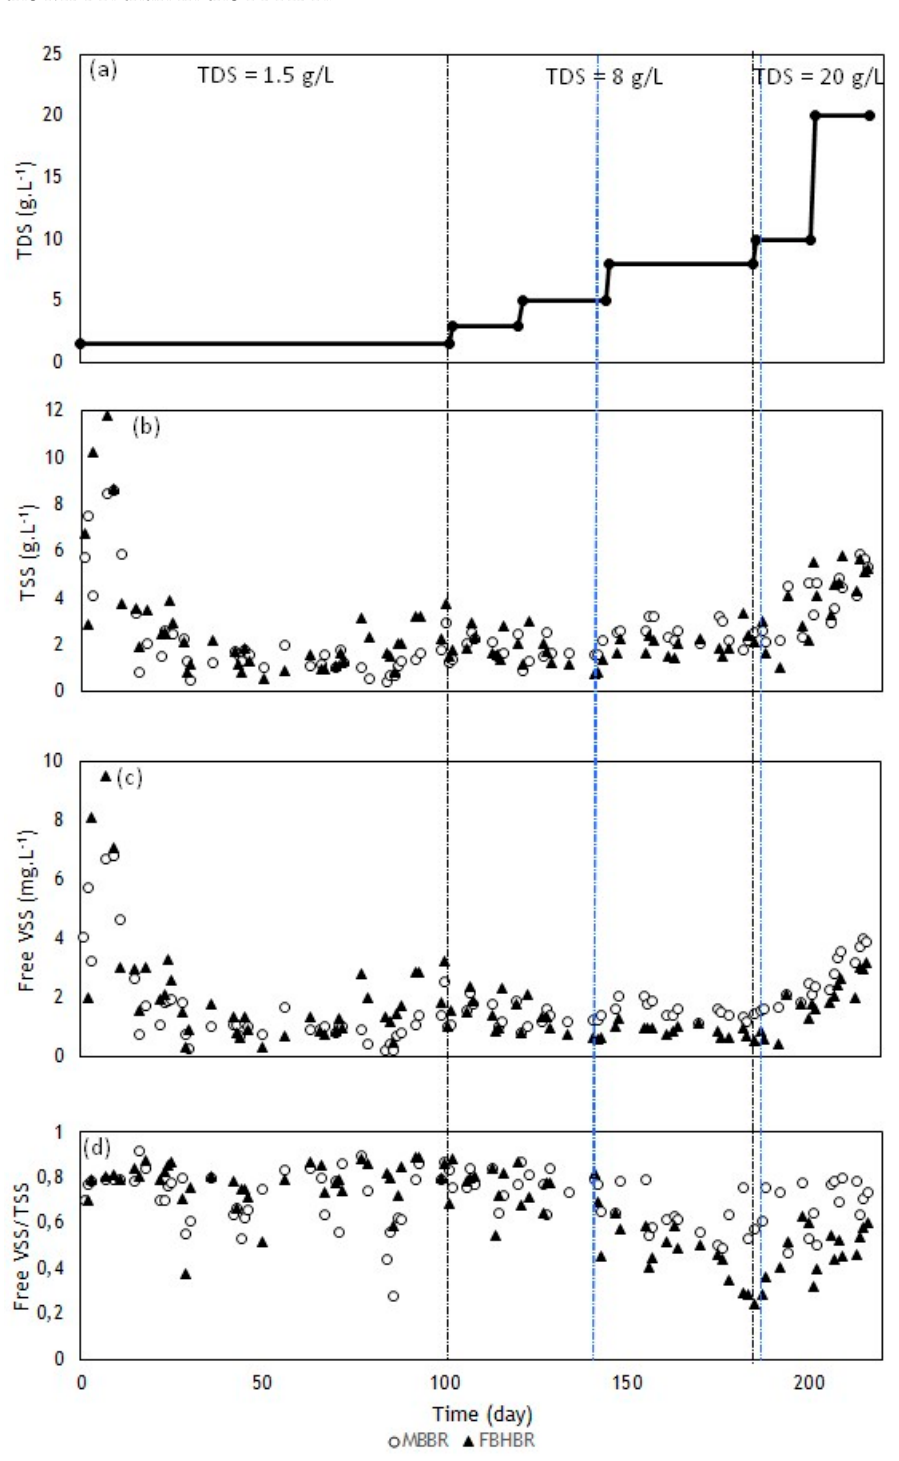
Figure 3. Evolution of solids concentrations in both MBBR and FBHBR during the experiment: TDS concentration ( a ), free TSS concentration ( b ), free VSS concentration ( c ) and free VSS/TSS ratio ( d ). To better understand the evolution of solids concentrations, values of free VSS/TSS ratios are plotted against time in Figure 3d. During the first step (TDS = 1.5 g · L − 1 ), free VSS/TSS ratios were high, reaching an average value of 0.8 in the FBHBR and 0.8